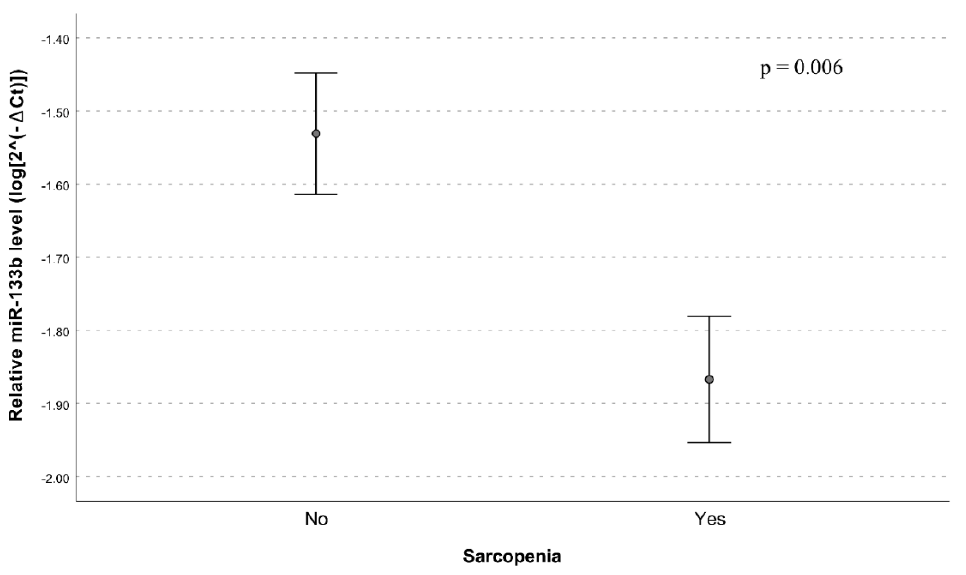
Figure 1. Relative miR-133b expression in plasma from sarcopenic and non-sarcopenic subjects. Data are reported as log 2 − ∆ Ct normalized to U6 expression together with mean ± standard error of the mean (SEM) and p -value computed by t-test ( p < 0.05).